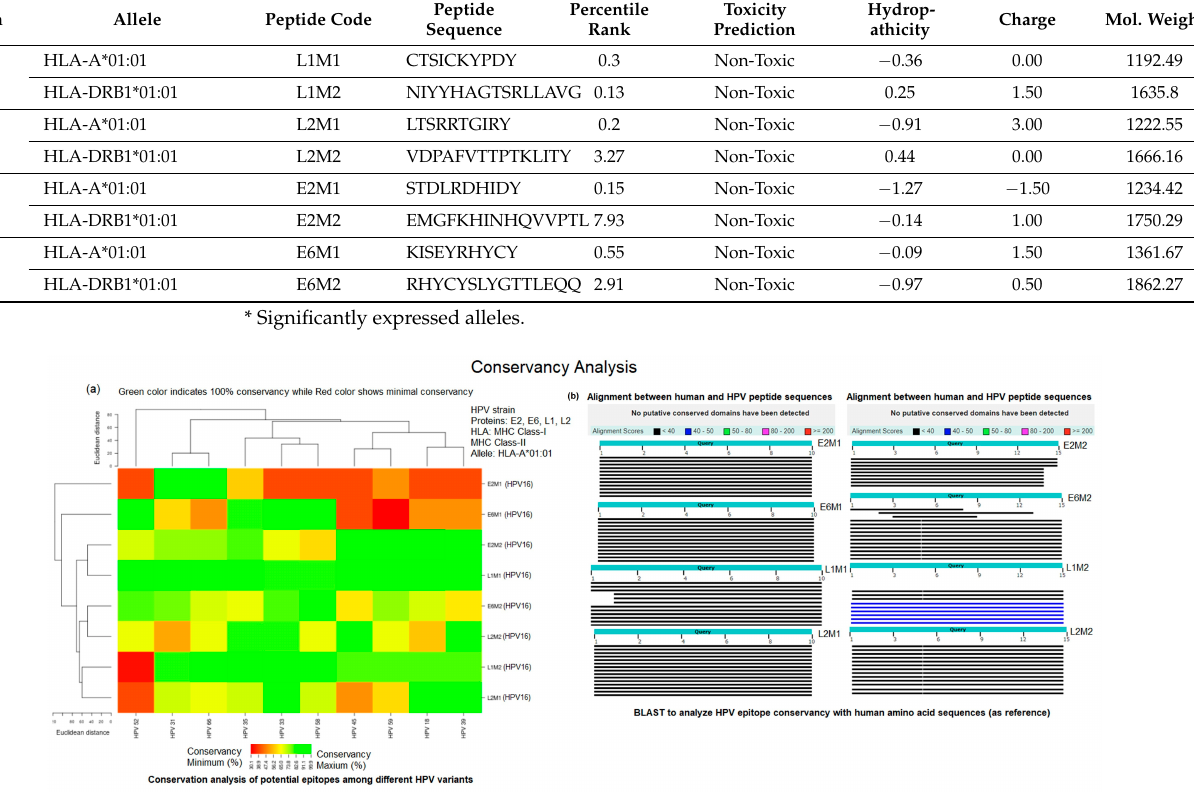
Figure 1. Conservation analysis ( a ) potential epitopes of HPV-16 strain among different variants of HPV sub-types ( b ) sequence alignment of potential epitopes against human proteome as reference to analyze conserved domains. Table 1. Predicted MHC class I and II specific epitopes of HPV antigenic proteins and their physio- chemical properties. (time-response curve) was observed at 240 µ g/500 µ L (Figure 2). We analyzed immune responses of rats to synthetic peptides 3 weeks post immunization. The rats were monitored on daily basis for these three weeks to observe side effects of the administered